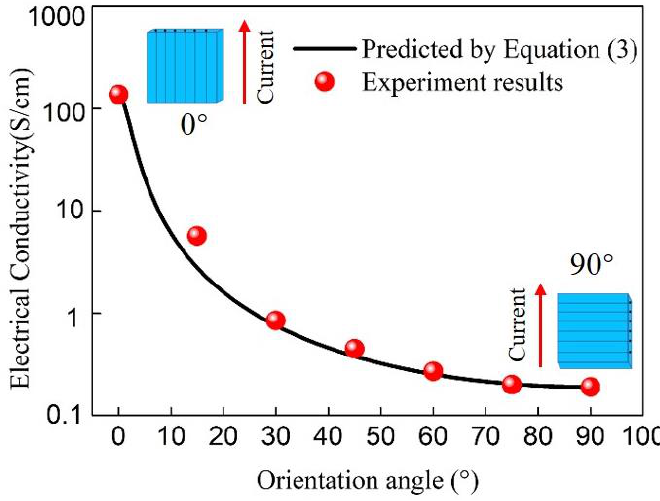
Figure 3. Electrical conductivity of the CFRP at different carbon fiber orientation angles.